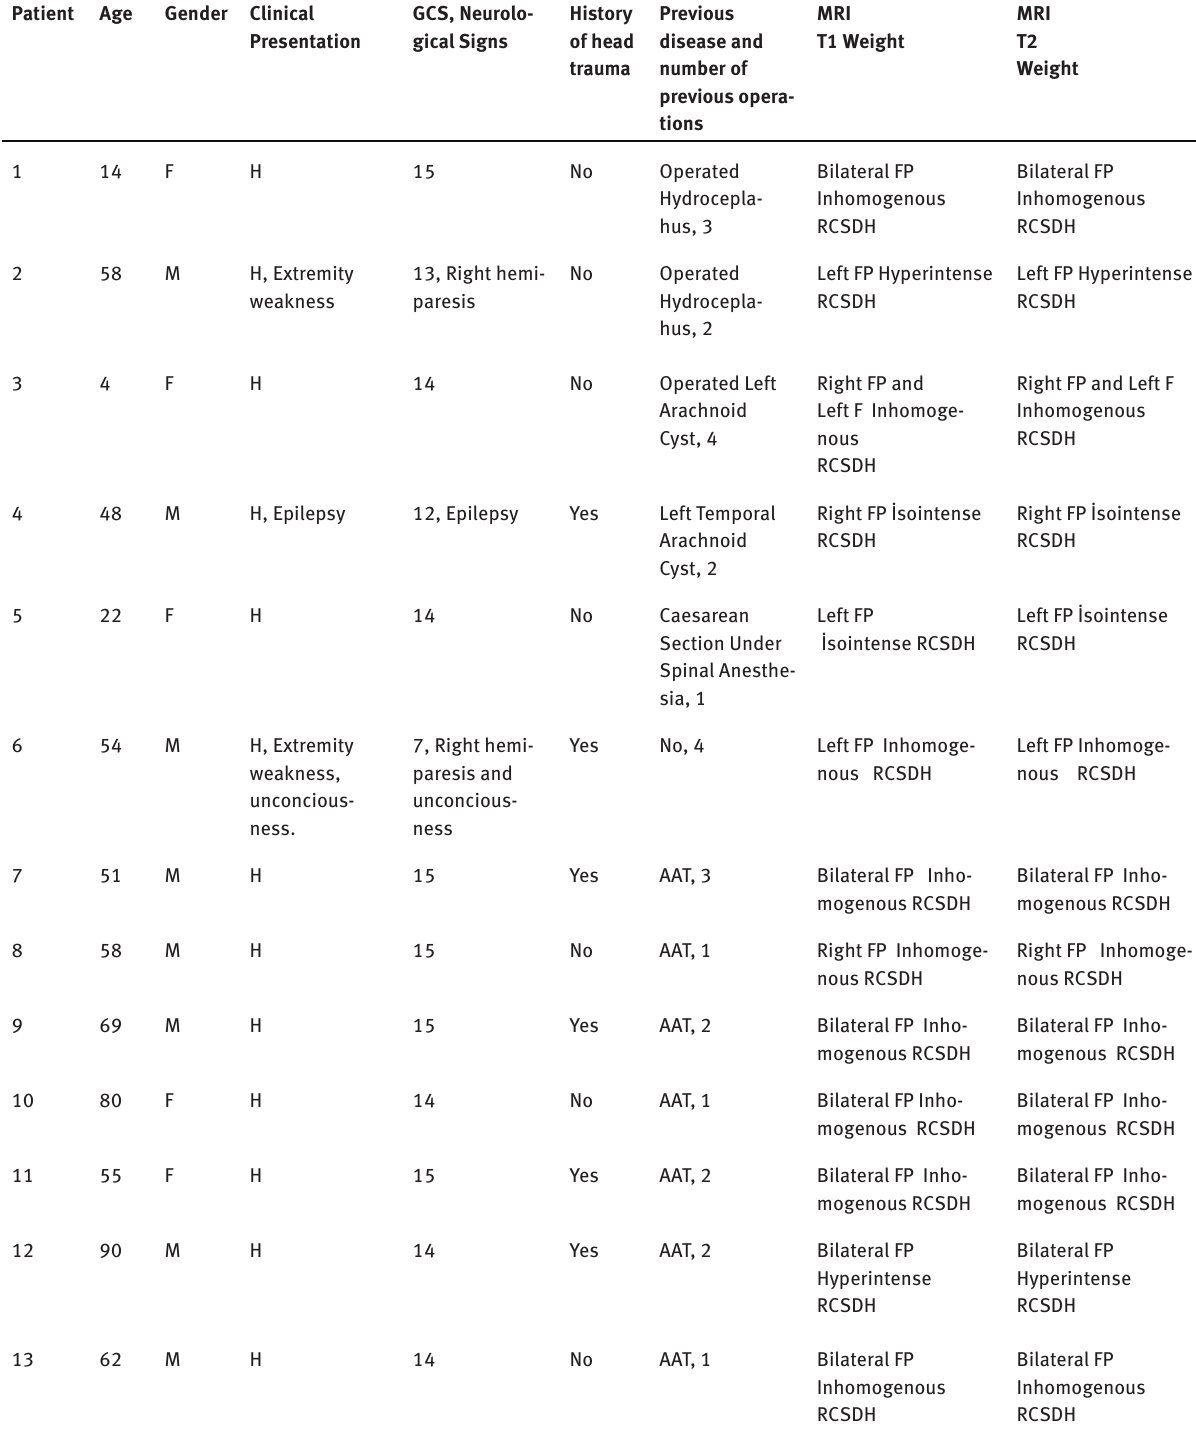
Table 1: Demographic data, clinical and imaging findings of the patients.